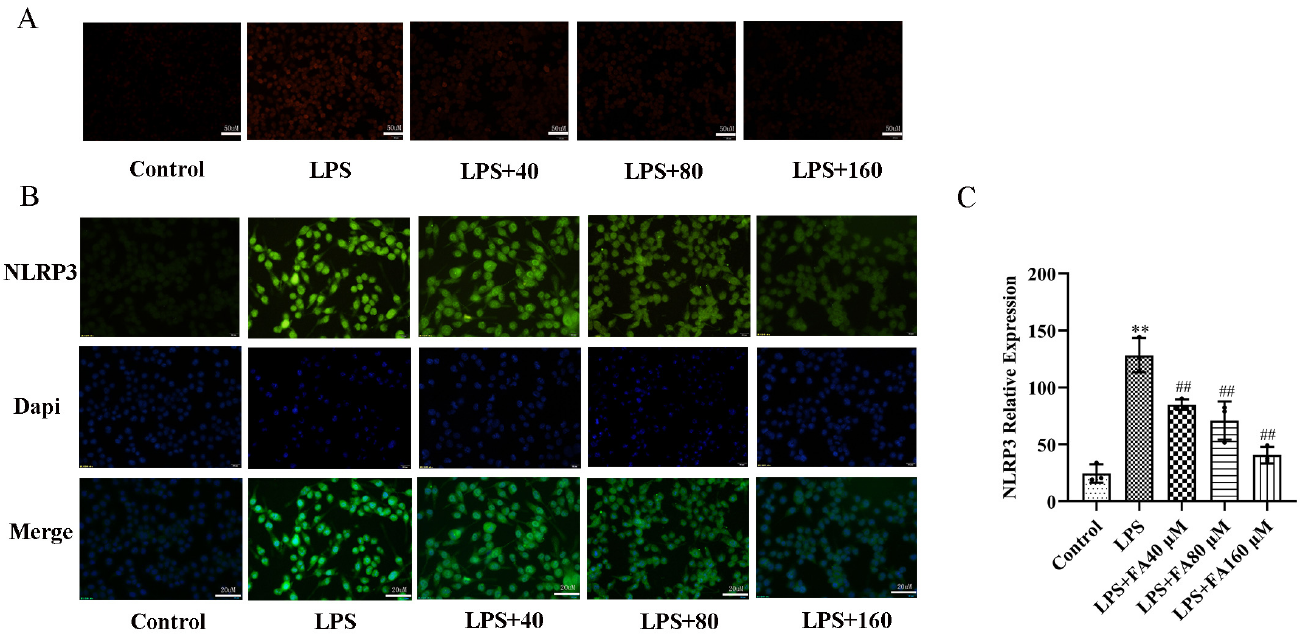
Figure 2. FA inhibited the LPS-induced ROS and NLRP3 (green) expression in a dose-dependent manner. ( A ) The expression of ROS (20 × magnification) was observed under a fluorescence micro- scope. DHE staining results. Scale bar = 50 µ M. ( B ) The expression of NLRP3 (50 × magnification) in BV2 microglia was observed via inverted fluorescence microscope. ( C ) This figure shows the results of fluorescence statistics of NLRP3. The nuclei were stained with Hoechst 33,342 (blue). Scale bar = 20 µ M. Data are means ± standard deviations (SDs) ( n = 3). ** p < 0.01, vs. control; ## p < 0.01, vs.